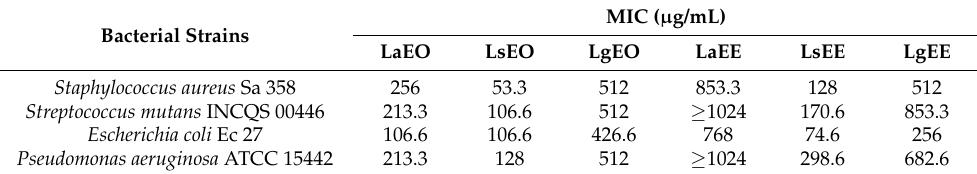
Table 3. Minimum inhibitory concentrations of essential oils and ethanolic extracts obtained from L. alba , L. sidoides , and L. gracilis